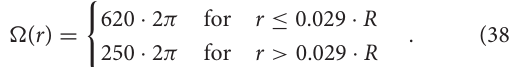
FIGURE 2 | Profiles of the poloidal flow components u t s and v t s (for s for